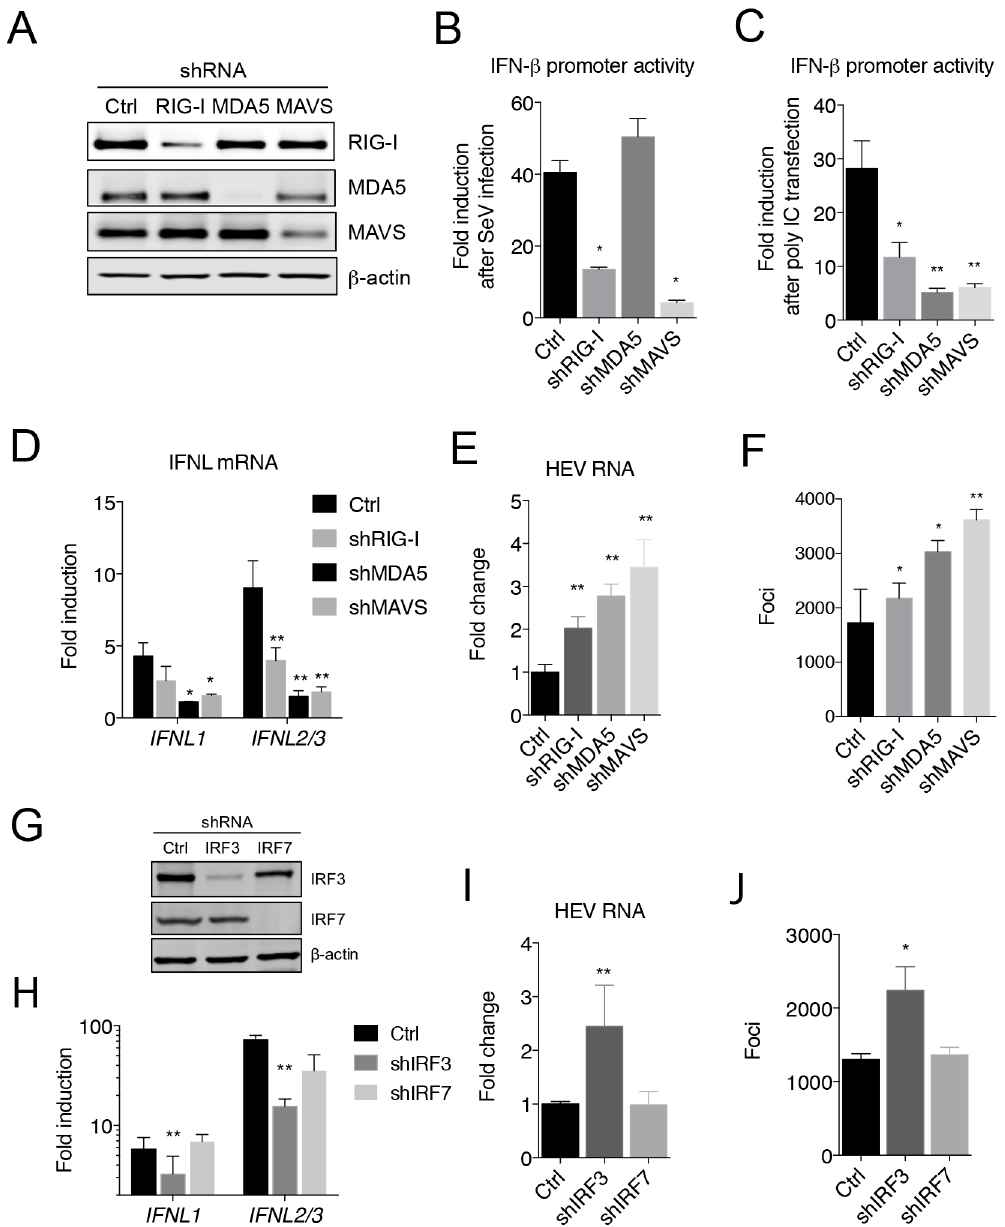
Fig 3. Signaling pathwaysinvolvedin HEV-induced IFN response. ImmunoblotsofRIG-I, MDA5,MAVSand β -actin inHepG2cellsexpressinggene-specificshRNA,or GFP(Ctrl). (B-C) IFN- β promoteractivityinHepG2cellswithdifferent geneknockdownfollowingSendaivirus(SeV)infection(B) orpolyIC transfection(C).CellsweretransfectedwithIFN- β - LucandTK-RLuc(for normalizationoftransfectionefficiency)20h priortoSeVinfectionor polyICtransfection.Cellswere lysedandluciferaseactivitywasdetermined20hafterSeVinfectionor12hafterpolyIC transfection.Dataarepresented asfoldchangesrelativetonon-treatedcells.Shownarerepresentativeresultsfromtwo independentexperimentseach performed intriplicate. (D-F) Effect ofRIG-I, MDA5orMAVSknockdownonHEVreplicationandhostIFN responses. ControlandshRNA-expressingHepG2cellswereinoculatedwithHEV(1000GE/cell).IFN- λ mRNAexpression (D), HEVRNAabundance (E), andHEV-positivefoci(F) weredeterminedat5 daysafterinfection.Theresultsshowthe mean ± SEMof2 independentexperimentsperformed induplicateeach. * P < 0.05; ** P < 0.01. (G) ImmunoblotsofIRF-3, IRF-7and β -actininHepG2cellstransducedwithlentivirusesexpressingGFP(Ctrl)orgene-specificshRNA.( H-J ) Effect ofIRF-3or IRF-7knockdownonHEVreplicationandIFN responses. ControlandshRNA-expressingcellswere inoculatedwithHEV(1,000GE/cell).IFN- λ mRNAexpression(H),HEVRNAabundance (I), andHEV-positivefoci(J)